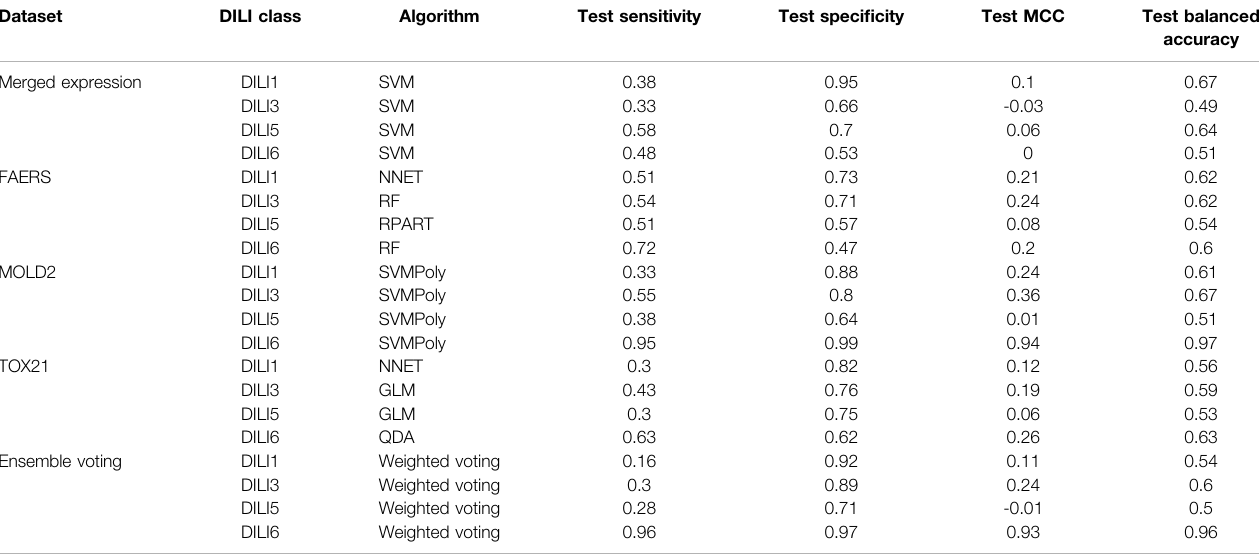
TABLE 5 | Testing Performance of Top Models. The testing result metrics from the best model built using each dataset as well as the ensemble voting model. Dataset Test balanced